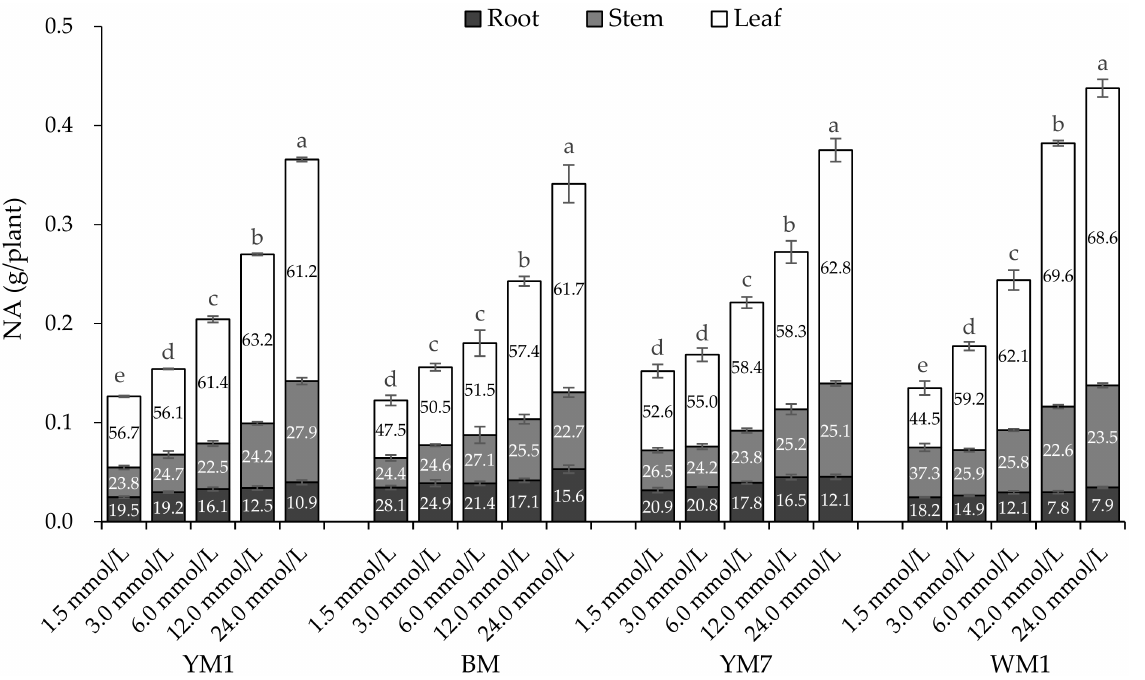
Figure 2. Effect of N treatments on N accumulation (NA) in hemp plant. Different letters above the columns within a cultivar represent significant differences in total N accumulation at p = 0.05. Numbers within the column represent the percentage of root, stem, or leaf N accumulation over the total N accumulation (%).